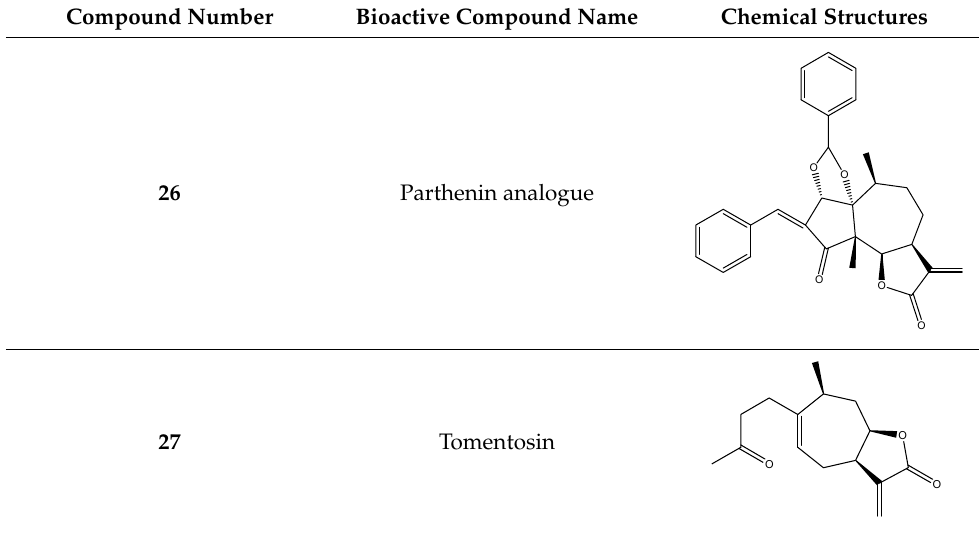
Table 2. Cont. Compound